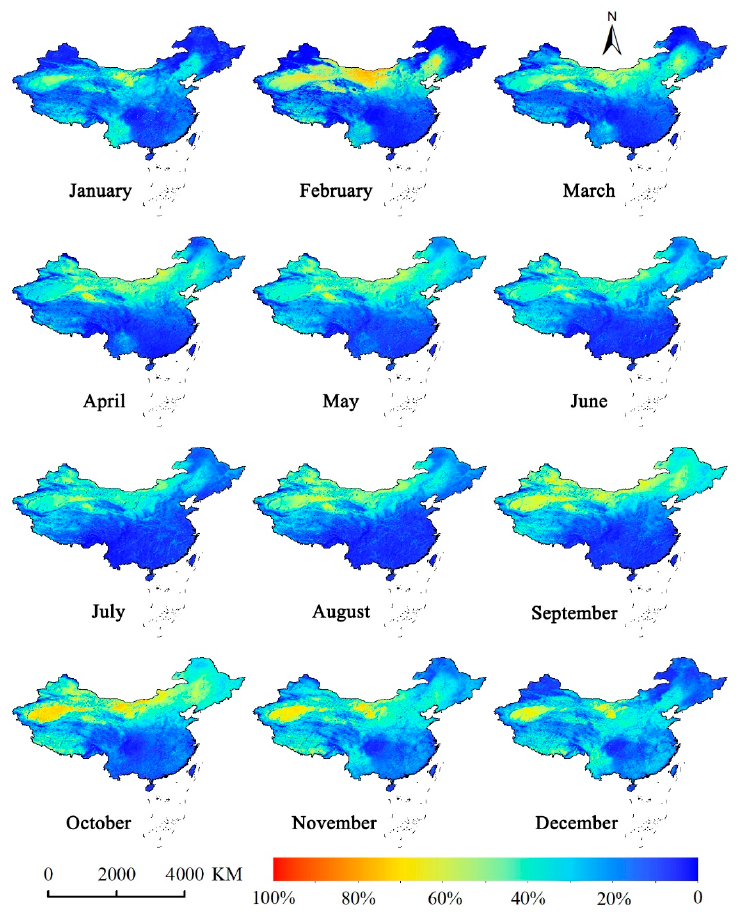
Figure 2. The monthly probability of acquiring cloud-free imagery in China (statistics based on the data from 1990 to 2019). There were noticeable regional differences in the monthly variations in the PACI (Figure 3). North China (NC), the Huang-Huai region (HHR), the Jianghan region (JhR), the Yangtze-Huaihe region (YHR), the Jiangnan region (JnR) and south China (SC) are located on the eastern coast of China (Figure 1). Their monthly variations of the PACI were similar. The PACI gradually decreased from winter to summer and gradually in- creased after autumn. From north to south, the PACI and the variation of the PACI grad- ually reduced. The highest PACI was 38.85% in February for NC, and the lowest was 16.71% in July, with a difference of roughly 20%. The highest PACI was 17.54% in SC, and the lowest was 5.26%, with a difference of approximately 12%. The monthly variation in southwest China (SWC) was smoother than that for the eastern coast. The monthly varia- tions of the PACI in northwest China (NWC), NM and northeast China (NEC) were simi- lar. The higher PACIs were in April, May and October, and the lower PACIs occurred in January, July and December. The variation in Tibet (XZ) differed from that in other areas. The highest PACI for XZ was 28.57% in November. In China, the highest PACI was 49.55% in October for NM, while the lowest was 4.65% in July for SWC.